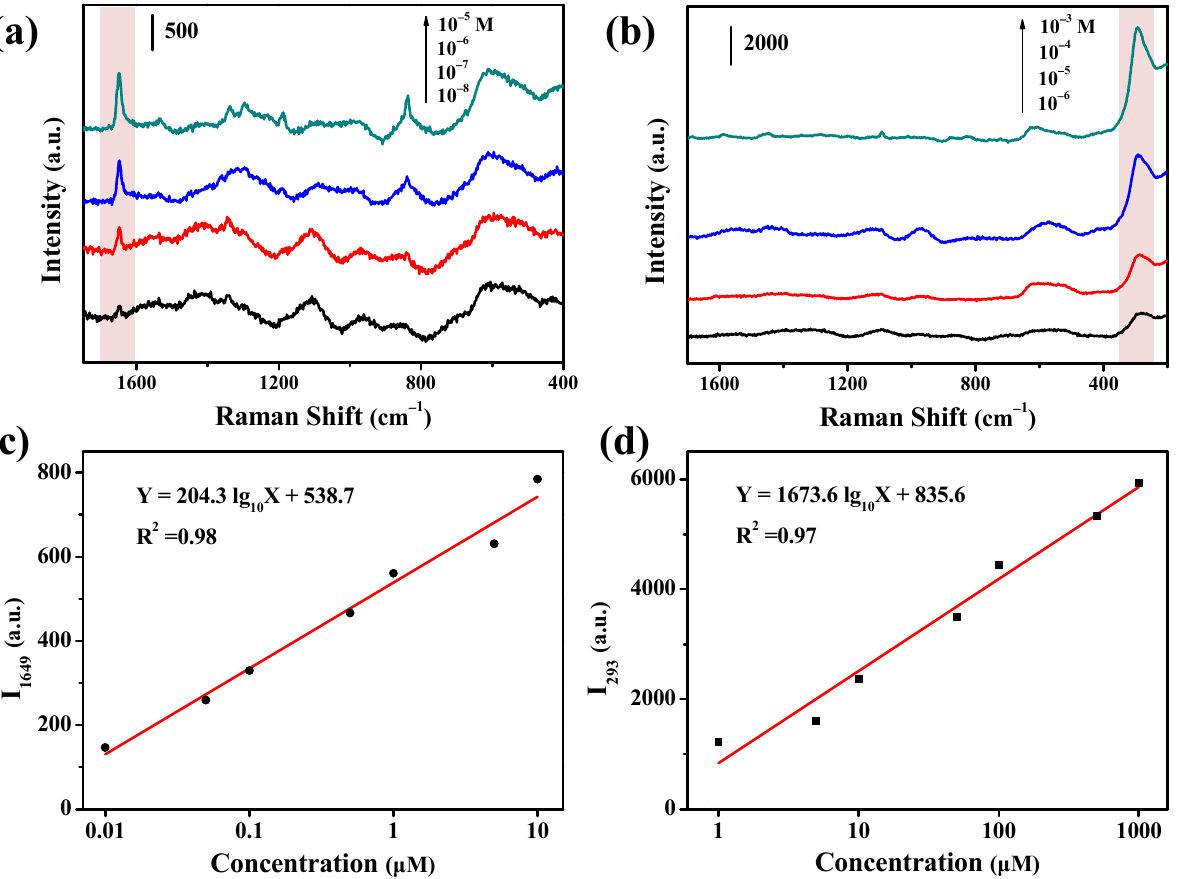
Figure 8. SERS spectra of ( a ) PQ and ( b ) SH at various concentrations on the Cu-Ag SERS chip. Linearity between the SERS intensity and log 10 (concentration) of ( c ) PQ and ( d ) SH by using their strongest peaks.